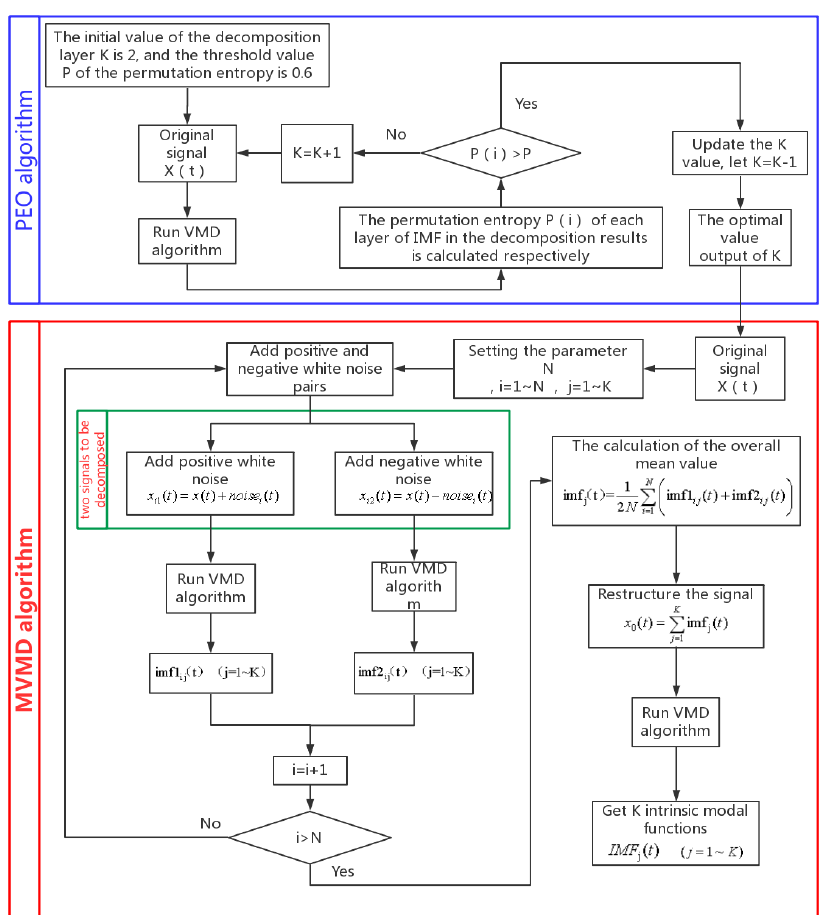
Figure 2. Flow chart of the Permutation Entroy Optimization- Modified Variational Mode Decomposition